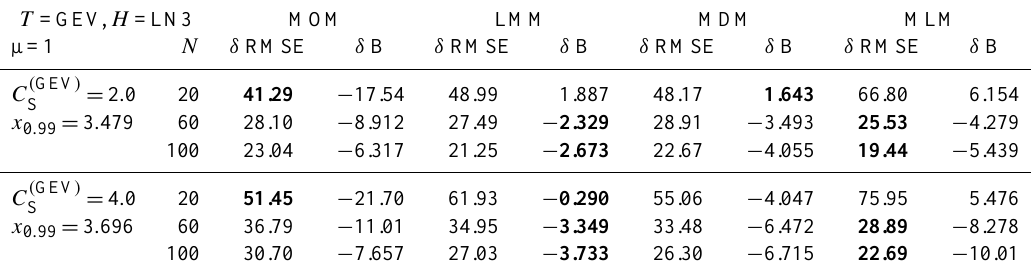
Table 10. Relative accuracy [ % ] of ˆ x 0 . 99 for a sample from GEV, assuming LN3